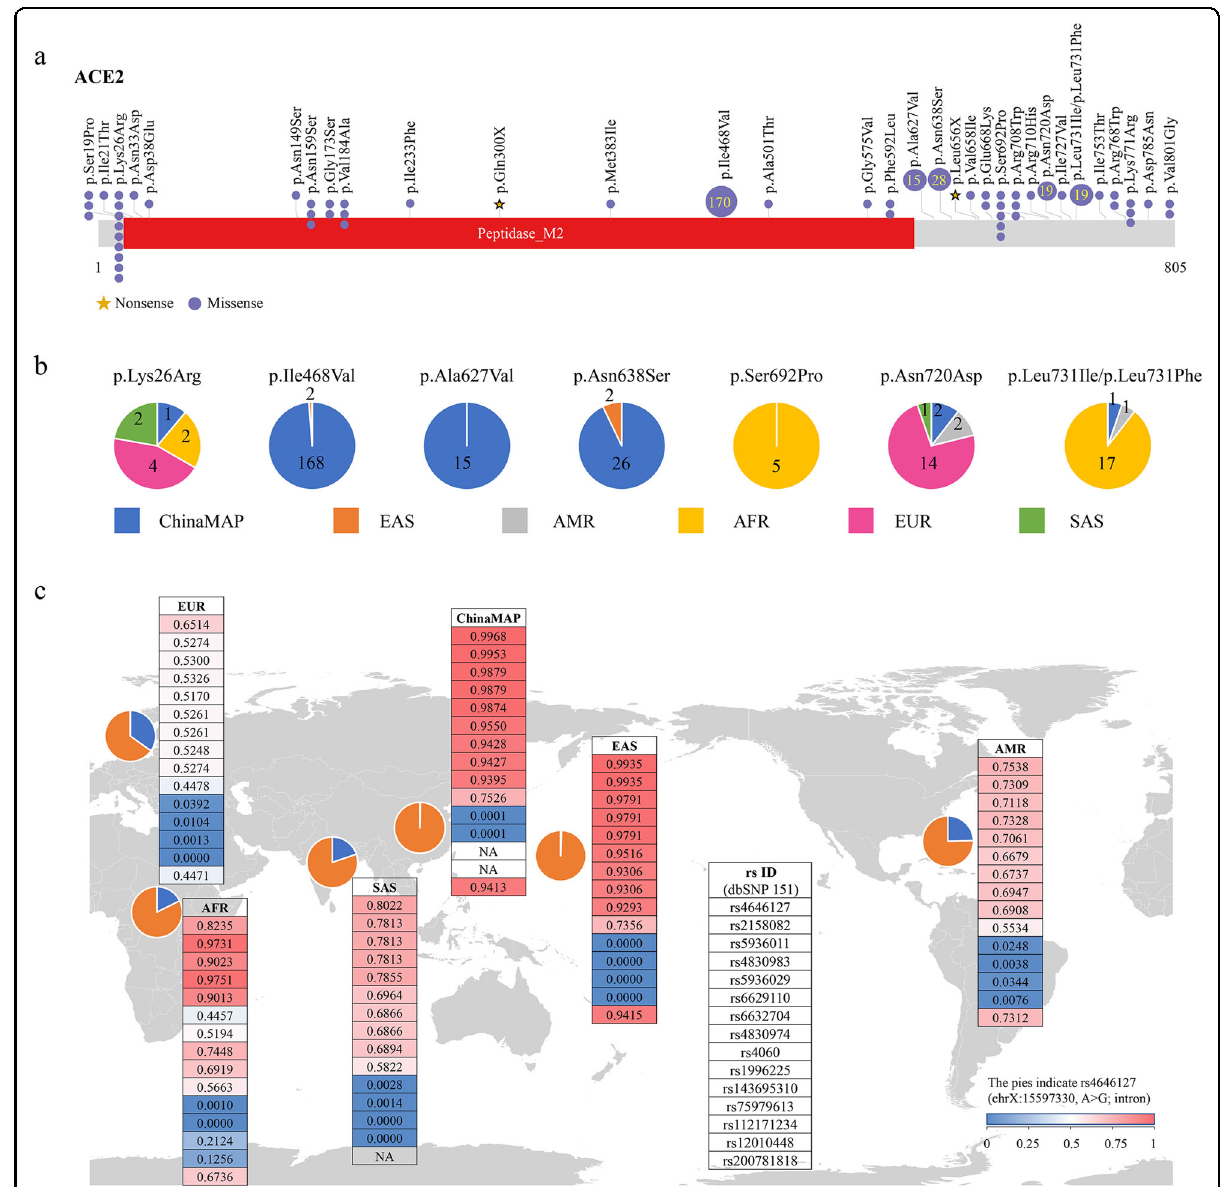
Fig. 1 The coding-region variants and eQTL variants for ACE2 in East Asian and other populations. a Schematics of 32 coding variants in ACE2 identi fi ed in the ChinaMAP and 1KGP databases. Yellow stars indicate the nonsense variants; dots indicate the missense variants. The number of samples with hotspot variants was marked. b The distribution of hotspot missense mutations of ACE2 in different populations. The colors indicate different populations. c The distribution and the allele frequencies of representative eQTL variants for ACE2 in different populations. Pie charts depict the allele frequencies of an intron variant of ACE2 (rs4646127) in the world. Orange color denotes the frequency of alteration allele, and blue color denotes the reference allele. The allele frequencies of 15 eQTLs for ACE2 gene are shown in tables. The color gradient from blue to red indicates the increasing of allele frequencies. The allele frequencies of INDEL variant rs200781818 were annotated by the gnomAD database. EAS, East Asian; EUR, European; AFR, African; SAS, South Asian; AMR, Ad Mixed